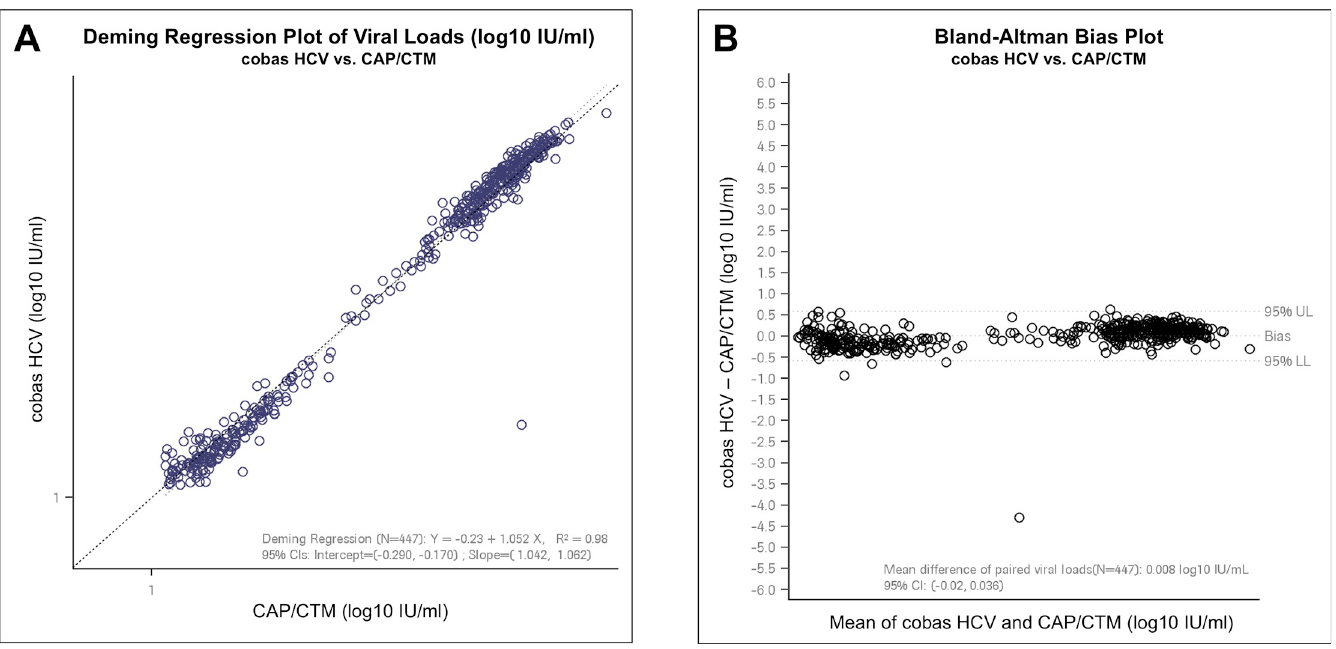
Fig 1. Deming Regression Plot of Viral Loads (log 10 IU/mL, A) and Bland-Altman bias plot (B) for cobas HCV vs. CAP/CTM (including one statistical outlier).